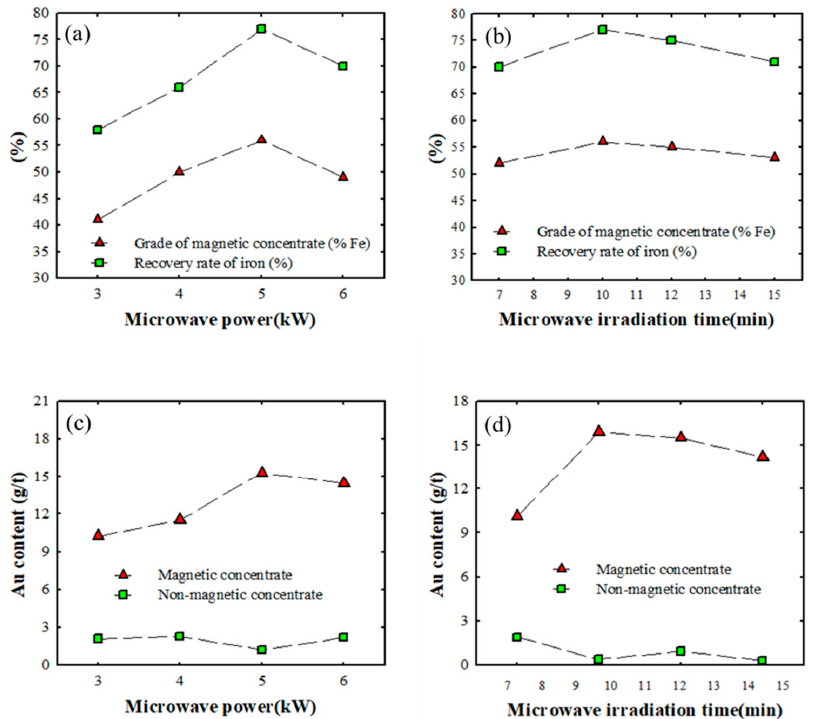
Figure 7. Effect of reduction roasting conditions (( a , c ) microwave intensity and ( b , d ) irradiation time) on the Fe ( a , b ) and Au ( c , d ) contents in the ores from the near ‐ surface oxide zone.